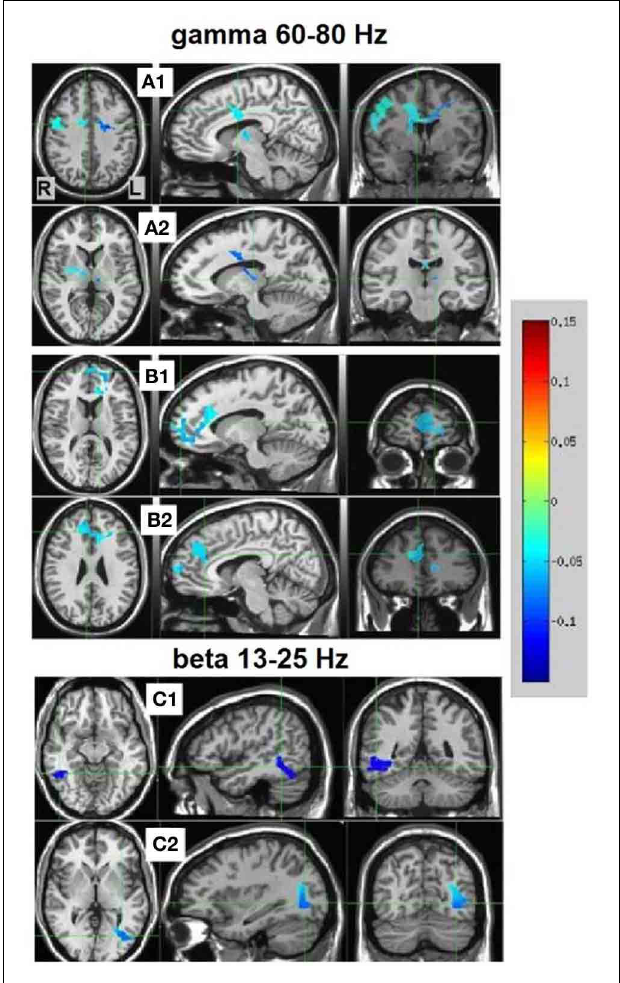
FIGURE 4 | NS vs. MS beamforming source estimates in the gamma (60–80Hz) and beta (13–25Hz) frequency bands. Axial, sagittal, and coronal views (left to right) of group ( n = 12) PSC source estimates overlayed on the Colin template. Note that in all images right and left sides are crossed. Color bar indicates PSC degree. Gamma band clusters: Cluster A is presented in 2 views. Crosshairs in (A1) are on the right medial anterior cingulate, and in (A2) on the left thalamus. Cluster B is presented in 2 views. Crosshairs in (B1) are on the left anterior cingulate, and in (B2) on the right anterior medial prefrontal cortex. Beta band clusters: Crosshairs in (C1) are on the right fusiform gyrus, and in (C2) on the left middle occipital